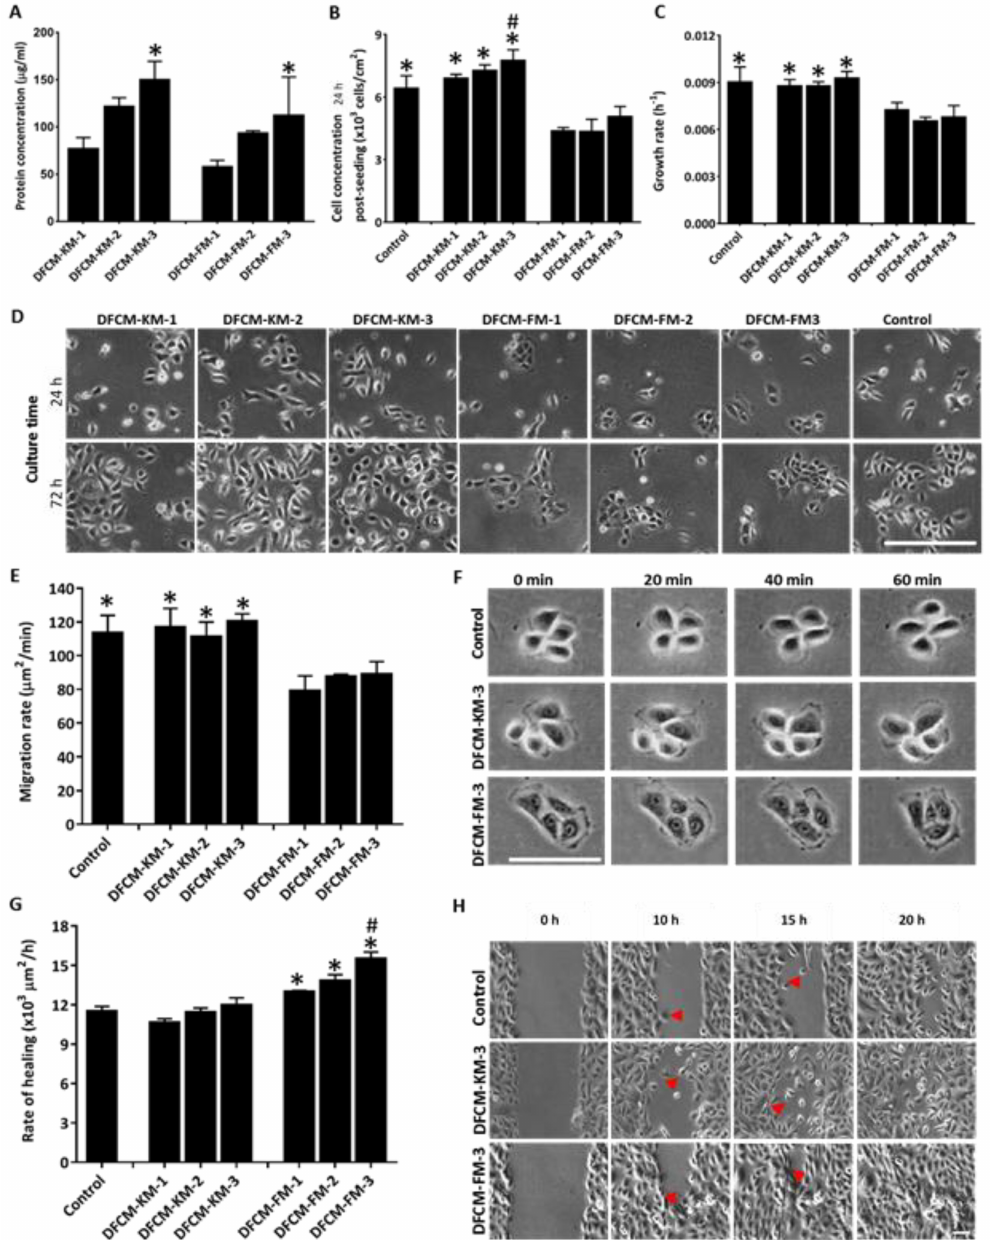
Figure 1. Preparation of DFCM and evaluation of its effects on keratinocytes re-epithelialisation. ( A ) Concentration of total protein in DFCM. Here, * indicates concentration of protein in DFCM- KM − 3 and DFCM-FM − 3 at 3 days incubation was significantly higher compared to that at 1-day incubation ( p ≤ 0.05). ( B ) Effect of different DFCM on keratinocyte attachment evaluated 24 h after cell seeding. Here, * indicates significantly higher compared to DFCM-FM; # indicates significantly higher compared to control and DFCM-FM ( p ≤ 0.05). ( C ) Keratinocyte growth rate under